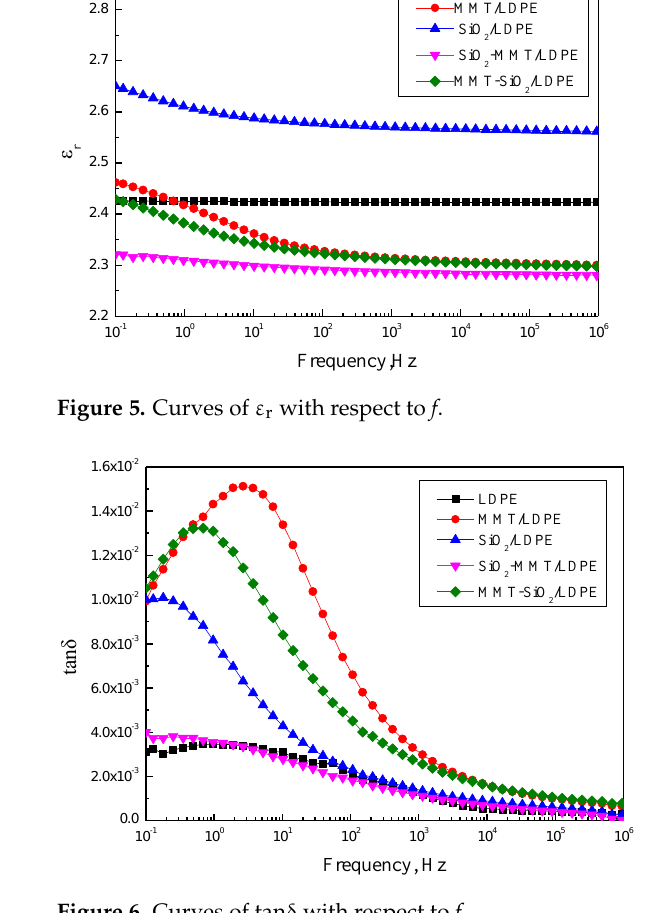
Figure 6. Curves of tan δ with respect to f .